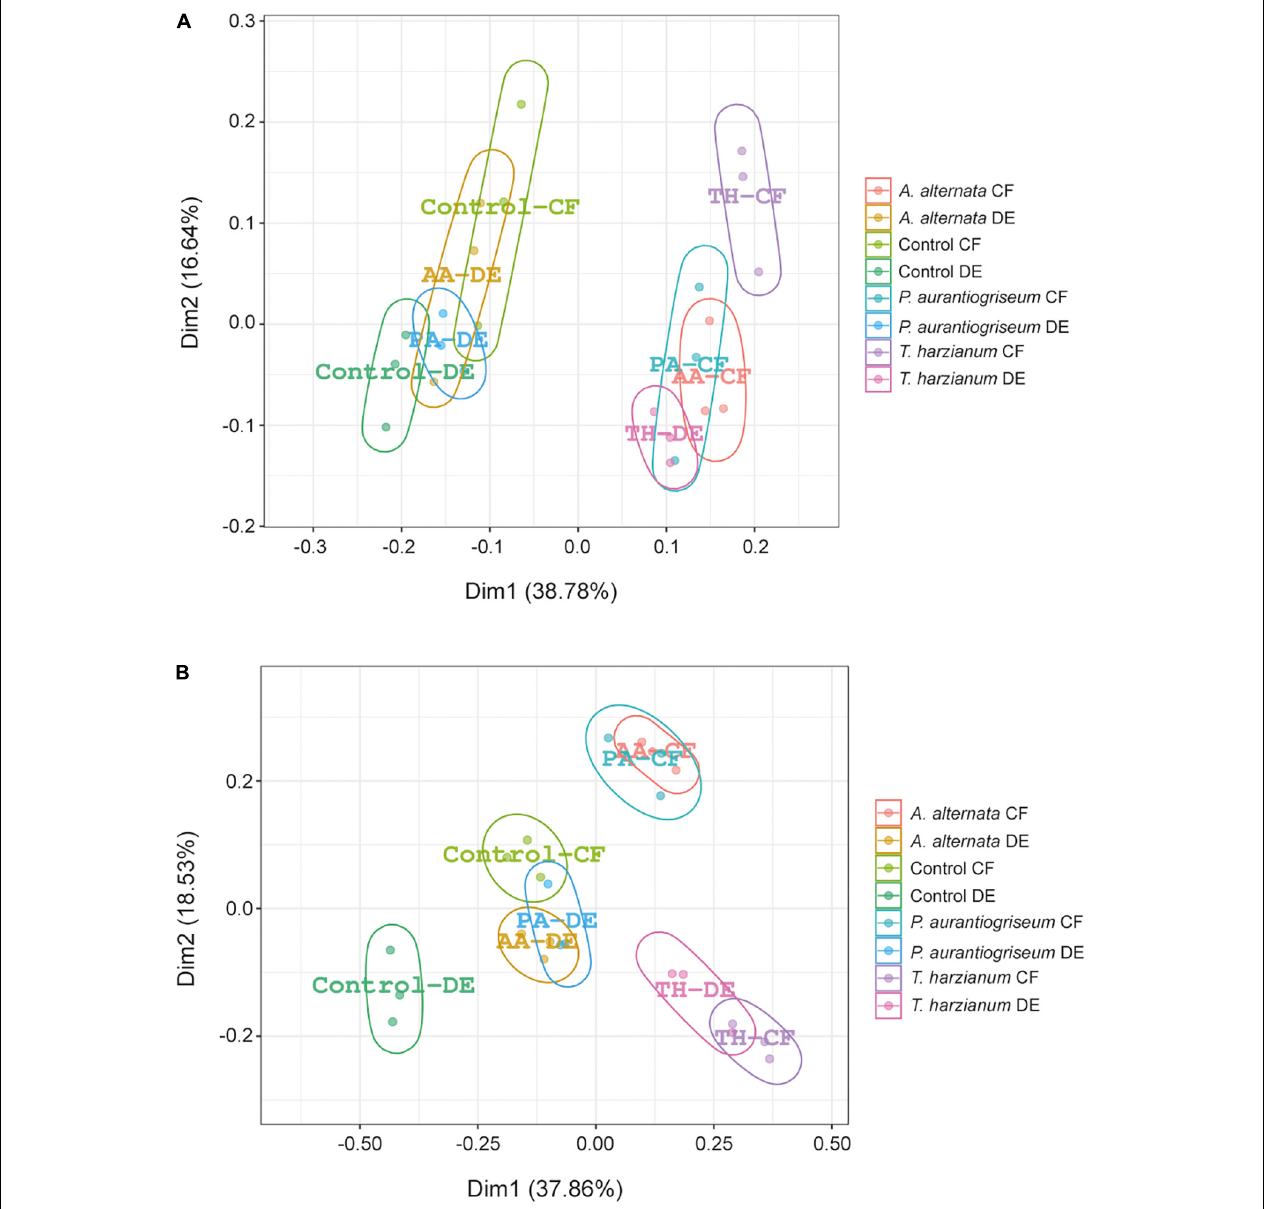
FIGURE 5 | Effect of soil application of fungal CFs and DEs on microbial diversity in soil. The graphics represent the results of principal coordinates analyses (PCoA) showing the β -diversities of the (A) bacterial and (B) fungal communities in soils treated with CFs and DEs of A. alternata (AA-CF and AA-DE, respectively), P. aurantiogriseum (PA-CF and PA-DE, respectively) and T. harzianum (TH-CF and TH-DE, respectively) and control